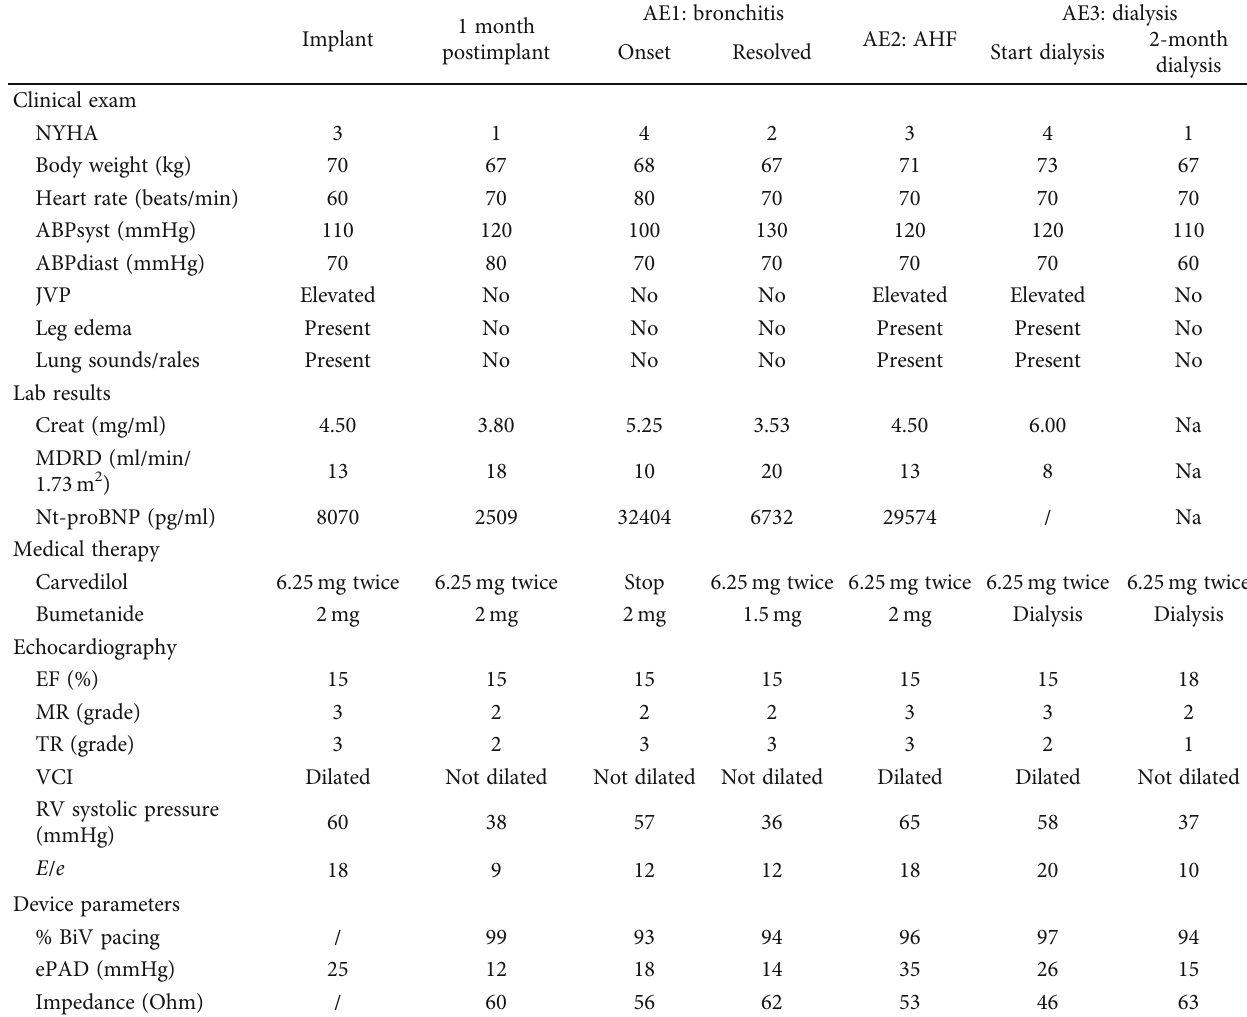
Table 1: Clinical characteristics, lab results, medical therapy, and echocardiographic and device parameters. NYHA: New York Heart Association class; ABPsyst: systolic arterial blood pressure; ABPdiast diastolic arterial blood pressure; Creat: creatinine; MDRD: modi fi ed diet renal disease; EF: ejection fraction; MR: mitral regurgitation; TR: tricuspid regurgitation; VCI: inferior caval vein; RV: right ventricular; BiV: biventricular; Na: not available; JVP: jugular venous